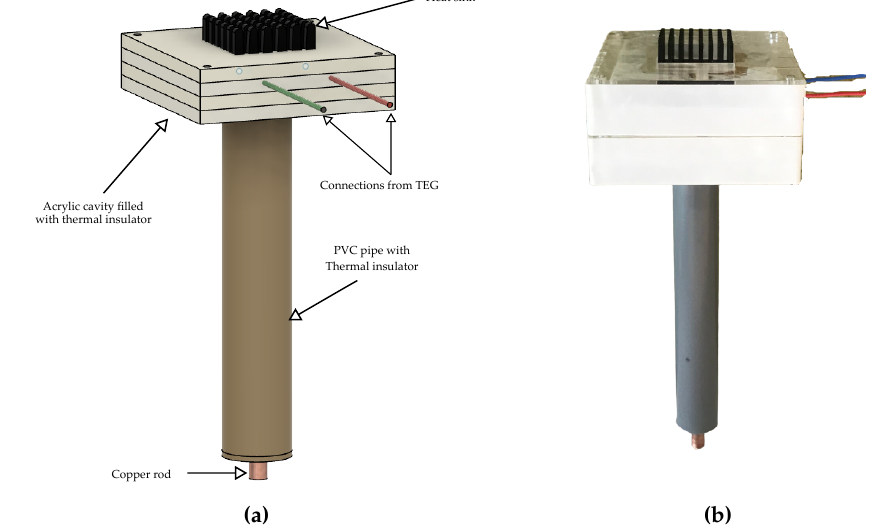
Figure 6. Design of energy converter unit ( a ) 3D model ( b ) Fabricated